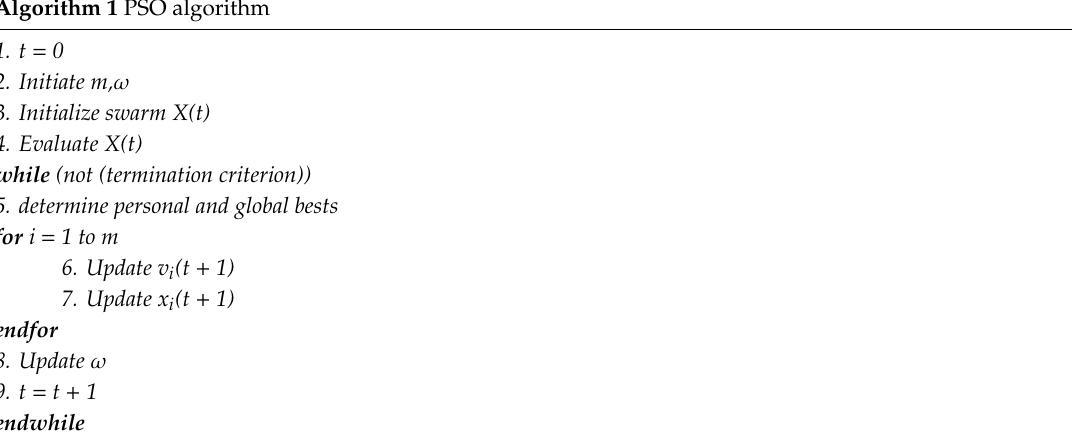
Algorithm 1 PSO